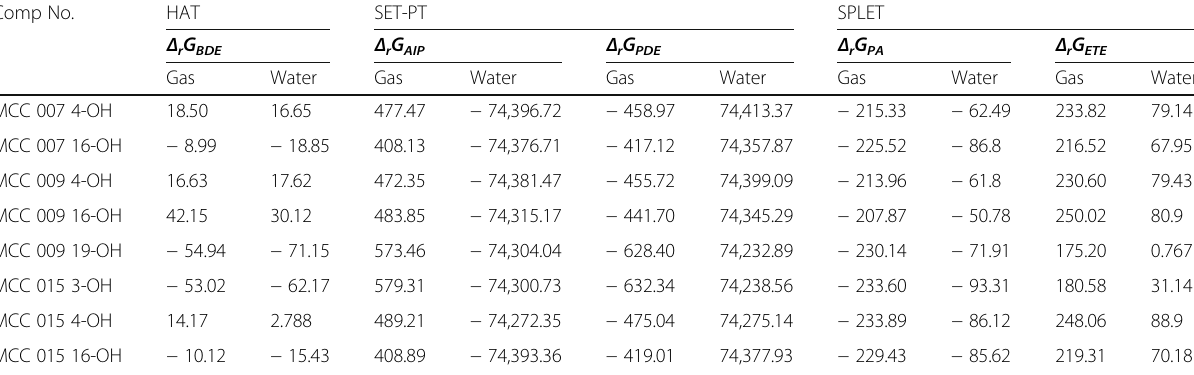
Table 4 Gibbs free energy changes ( Δ r G in kJ/mol) of scavenging CH 3 OO· radical by curcumin derivatives at the B3LYP/6-311G*/6- 31G* level in vacuum and water Comp No. HAT SET-PT SPLET